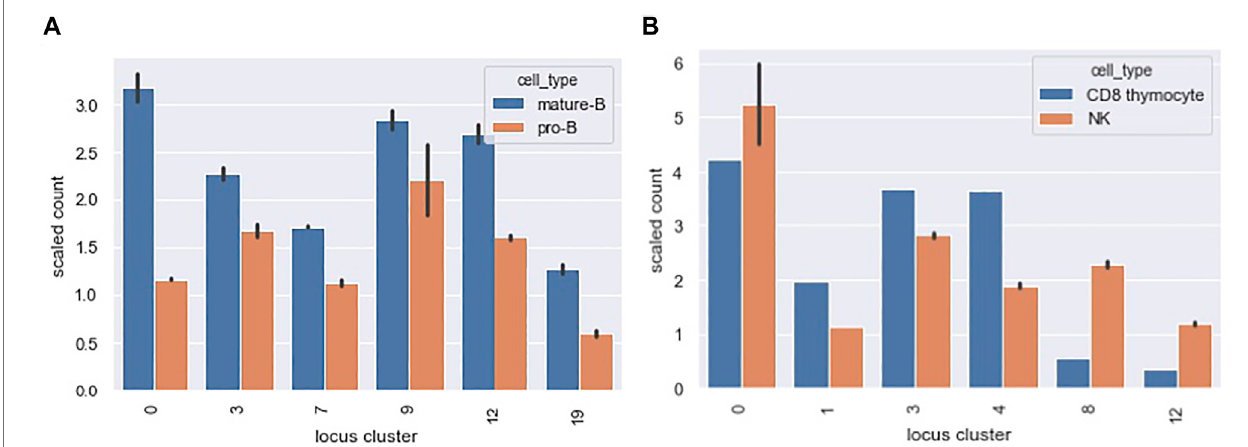
FIGURE 10 | Distribution of PAX5 and EOMES ChIPseq peaks across locus clusters. The bar graphs show a scaled count ( y -axis) of the number of loci in a locus cluster ( x -axis) that contained a ChIPseq peak for (A) PAX5 and (B) EOMES ChIPseq datasets. Scaled counts took into account the different sizes of our 20 locus clusters.Ascaledcountabove1representsanenrichmentofpeaksaboveanexpectationunderauniformnull.ThelocusclustersenrichedforPAX5ChIPseqpeakshad a statistically signi fi cant association with accessibility in pro-B and mature B cell types and we found an analogous association for EOMES peaks, see text for